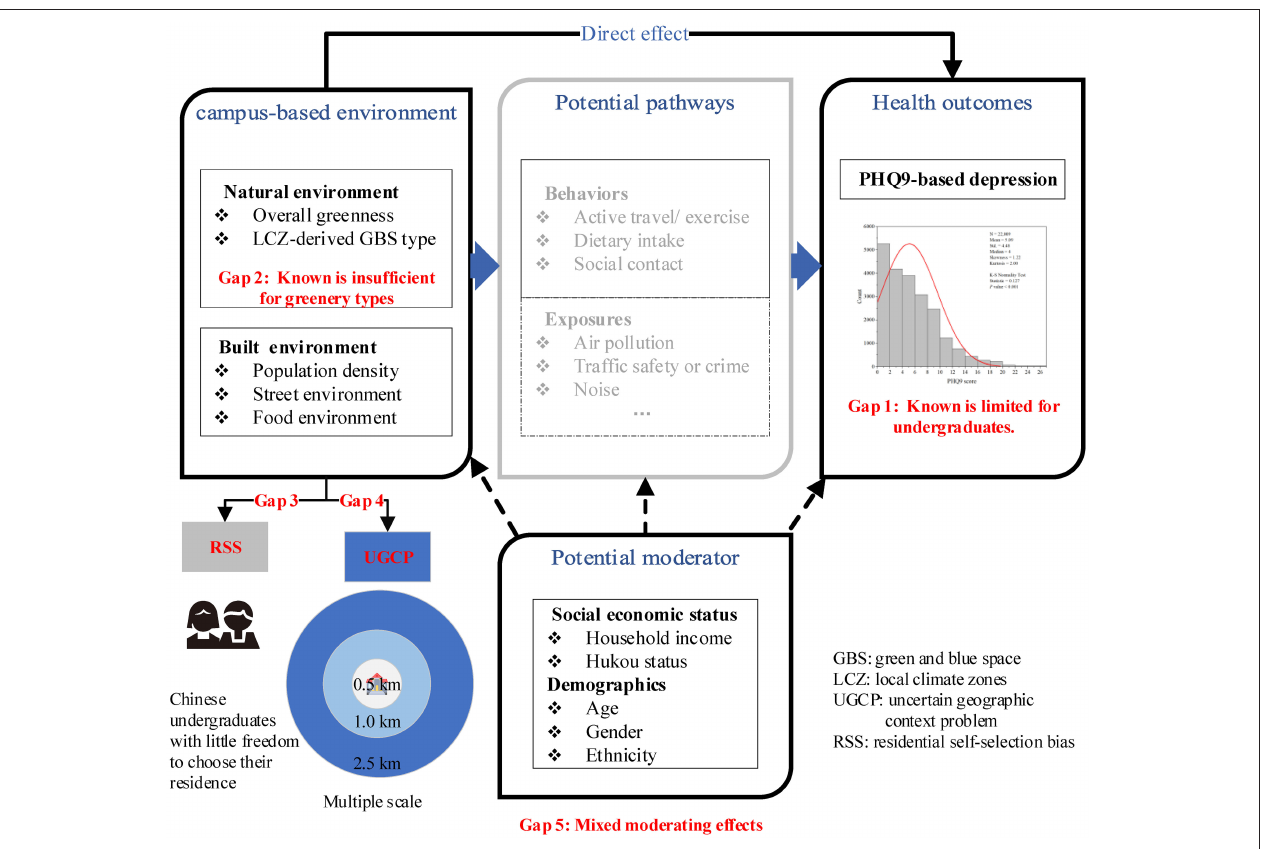
FIGURE 1 | Conceptual framework illustrating how campus-based environmental factors affect